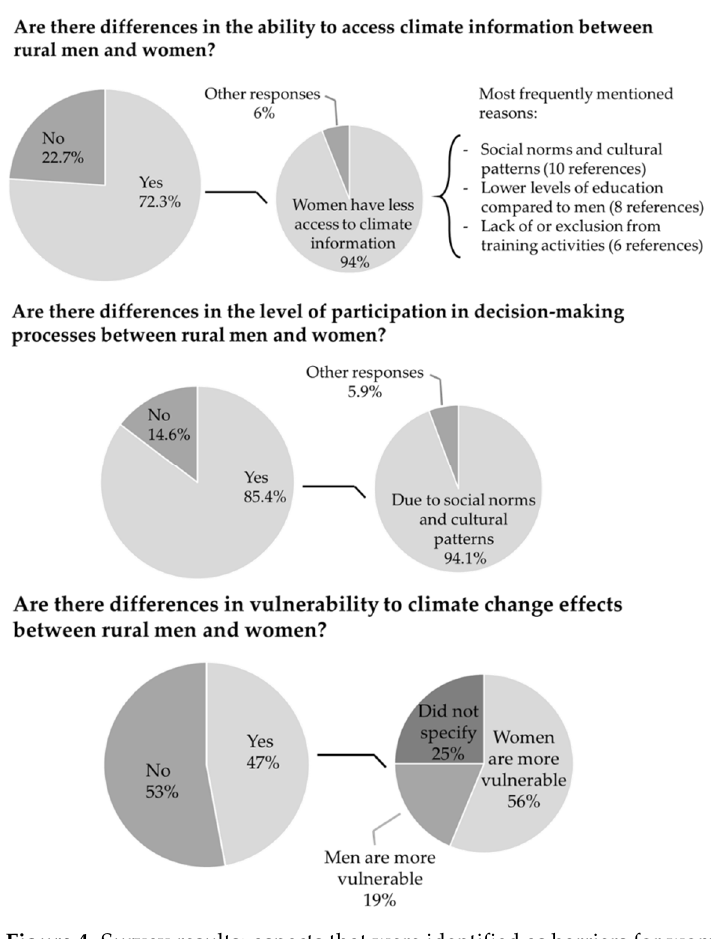
Figure 4. Survey results: aspects that were identified as barriers for women in the rural Highlands of Guatemala.